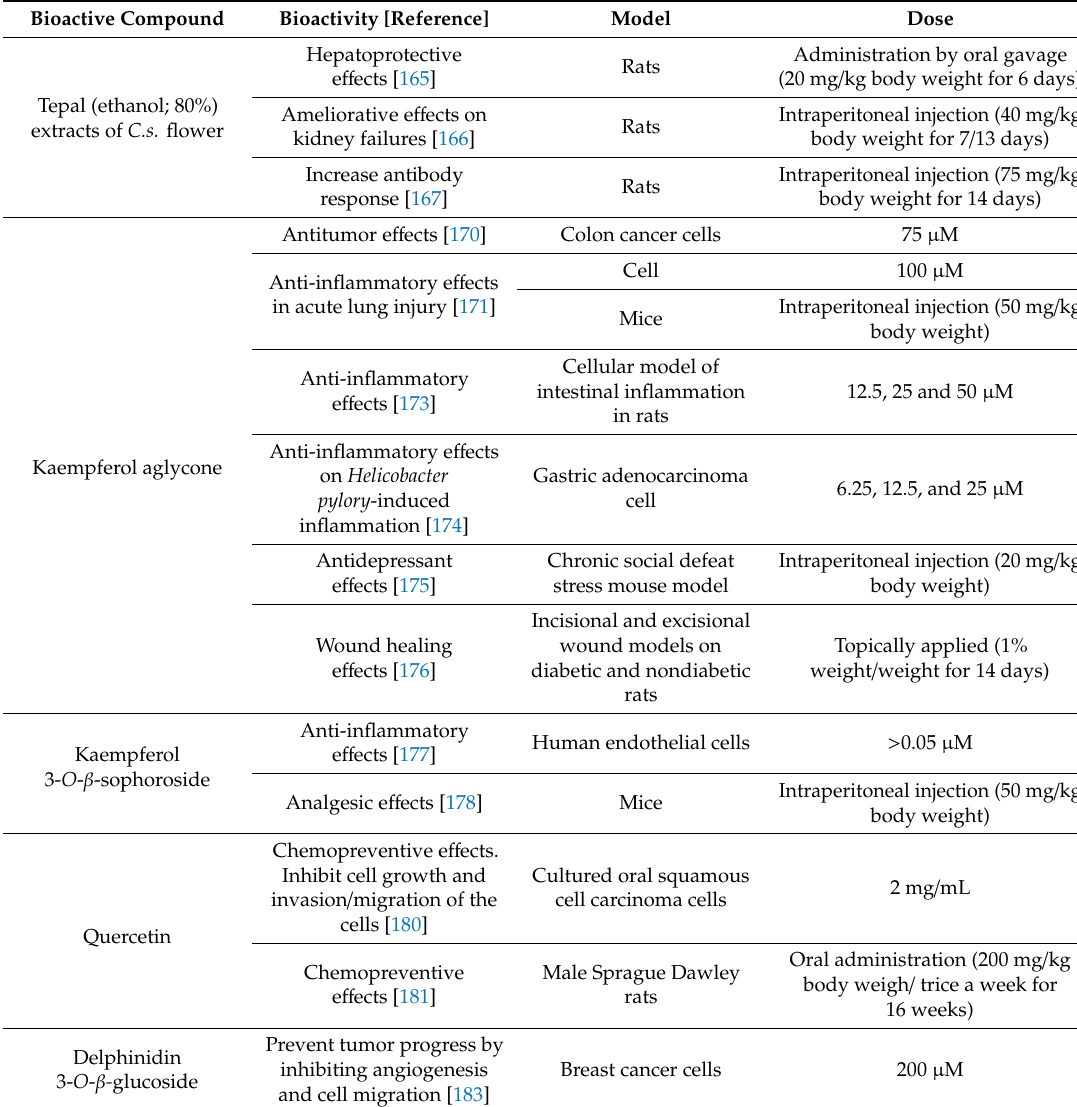
Table 3. Summary of the main bioactivity of phenolic compounds of sa ff ron and floral bioresidues of Crocus sativus L.